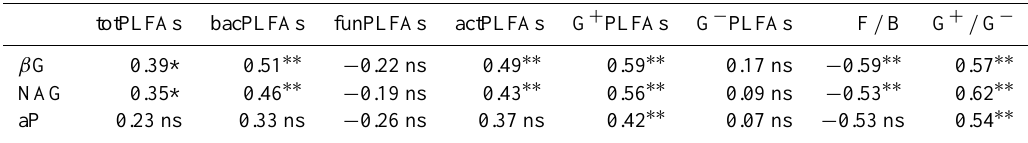
Table 3. Pearson correlations between soil enzyme activities and microbial PLFAs. totPLFAs bacPLFAs